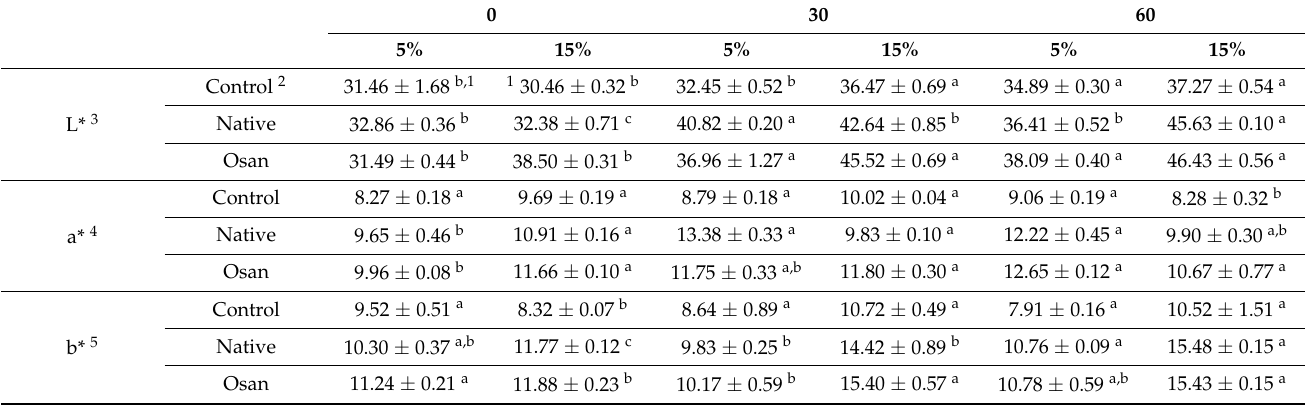
Table 9. The effect of octenyl-succinylated (Osan) corn starch, native starch and animal fat on the color characteristics of cooked meat patties at − 20 for different